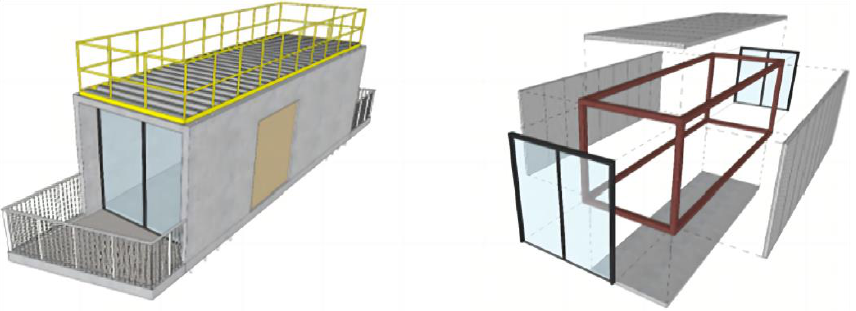
Figure 3. Reinforced concrete and steel PPVC modules of Wisteria, an engineering case in Singapore. Reprinted with permission from Ref. [18] © 2019, Elsevier Ltd.